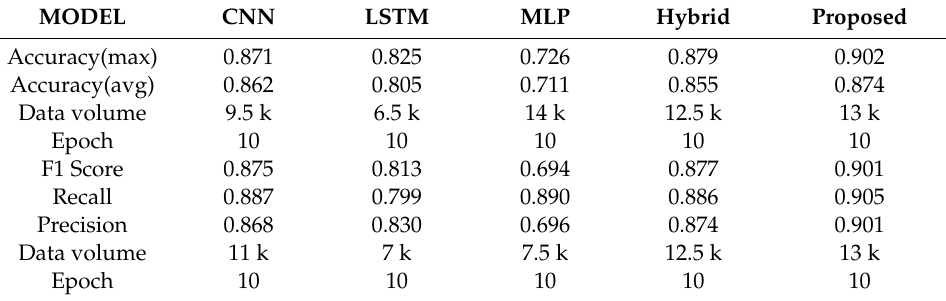
Table 4. Experimental results according to optimal data